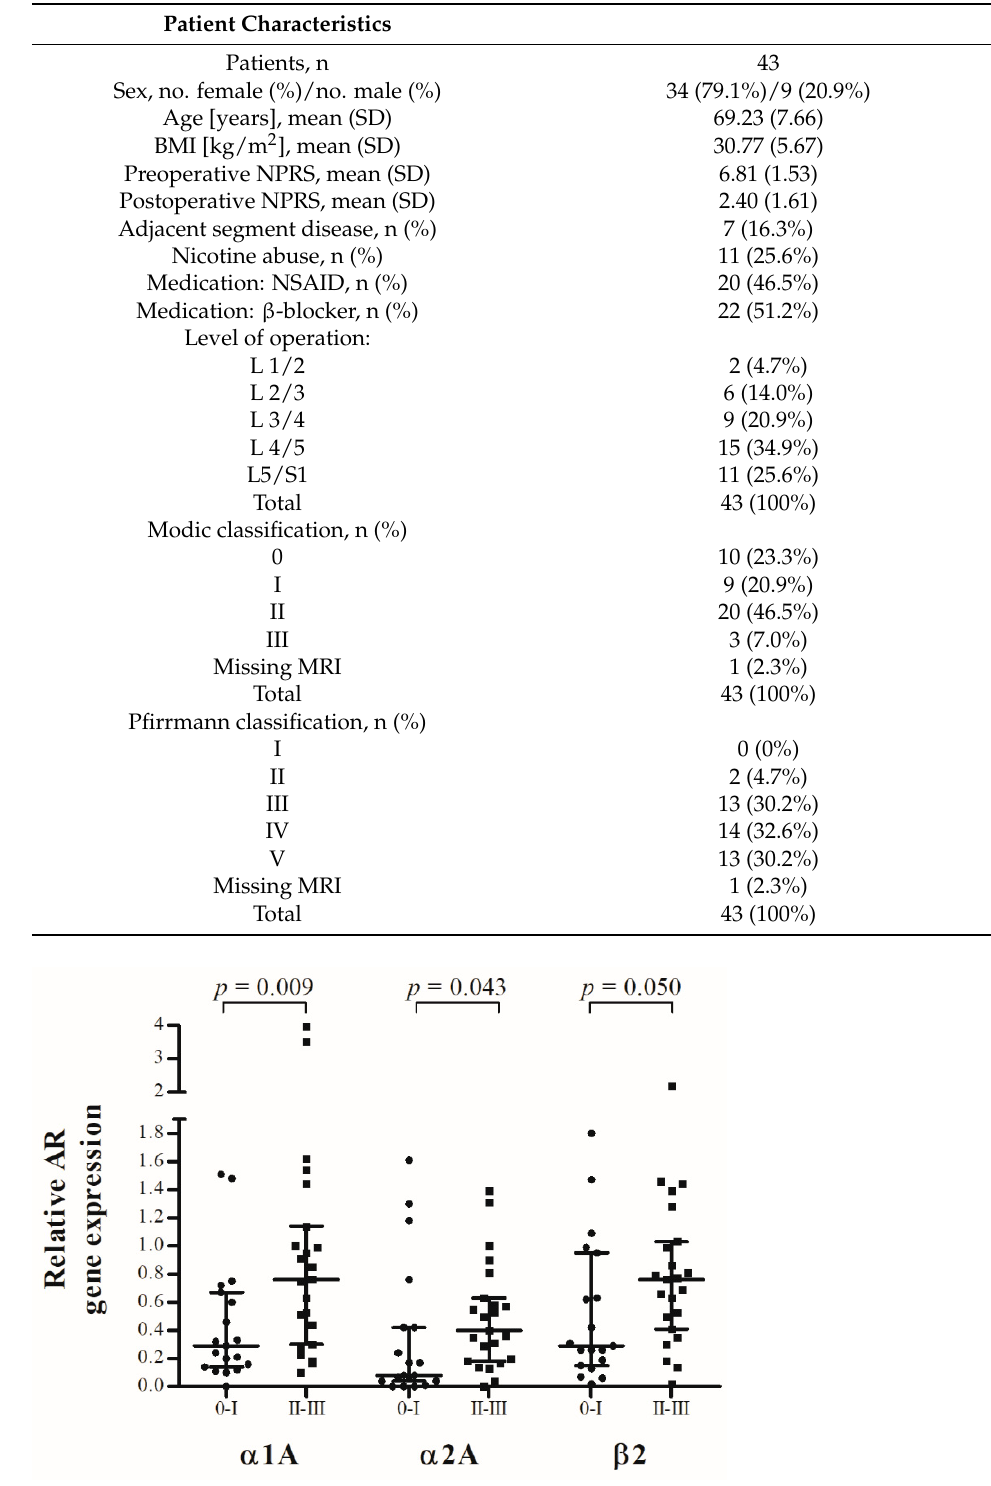
Figure 1. Correlation between relative AR gene expression in IVD tissue and radiological changes of the vertebral endplates (Modic classification). Modic 0 and I (black circle) as well as Modic II and III (black square) were each assigned to one group. Each black reference point represents an individual patient (n = 42). Data represent medians with interquartile range.